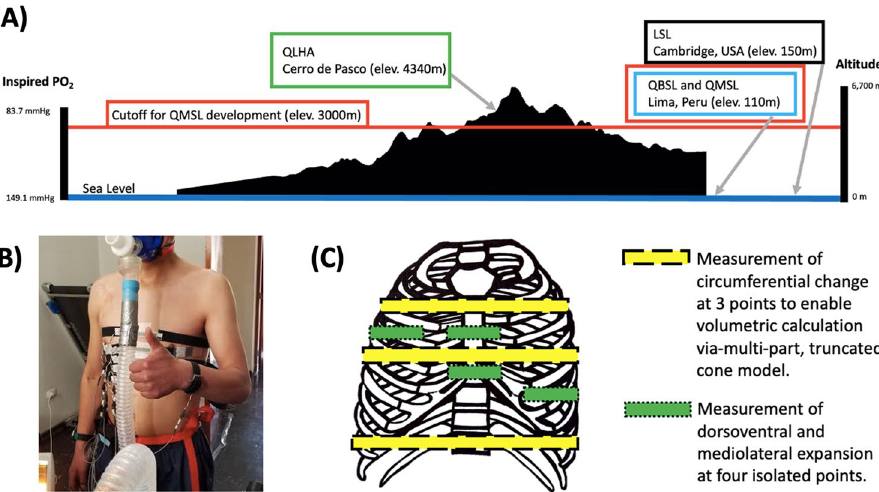
Figure 1. ( A ) The partial pressure of inspired oxygen decreases with elevation. Participant populations were from different oxygen environments and experiments took place at different altitudes. ( B ) A participant outfitted with our nanocomposite devices, mask, and spirometer. ( C ) Approximate device placement on human participants (ventral view) corresponding to thoracic circumference measurements.